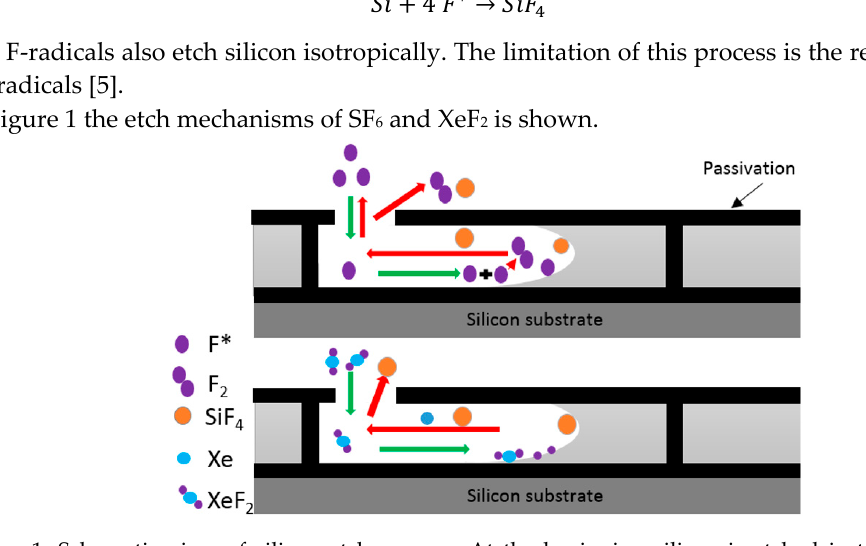
Figure 1. Schematic view of silicon etch process. At the beginning silicon is etched isotropic (all direction). As soon as the sacrificial silicon is cleared to the bottom oxide there is only lateral undercut restricted by the oxide filled trench